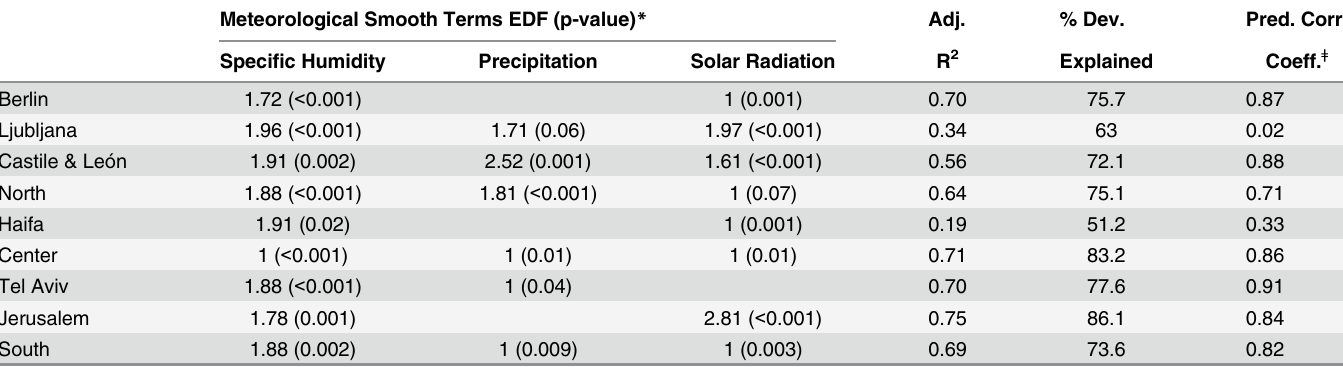
Table 2. Model 1 (with specific humidity) regression parameters. Models were adjusted for previous weeks ’ influenza activity. Meteorological Smooth Terms EDF (p-value) * Adj. % Dev. Pred. Corr. Speci fi c Humidity Precipitation Solar Radiation R 2 Explained Coeff.